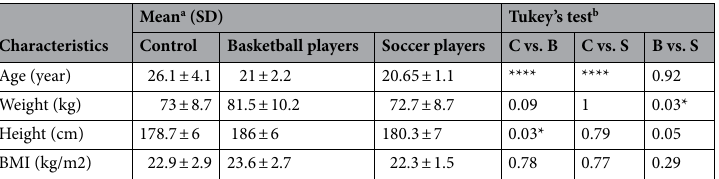
Table 1. Participants’ characteristics. a Measurements’ mean of controls (C), basketball players (B) and soccer players (S); BMI = body mass index. b Tukey’s test was performed by Graphpad Prism 6 (*p-value < 0.05), (****p-value < 0.0001).